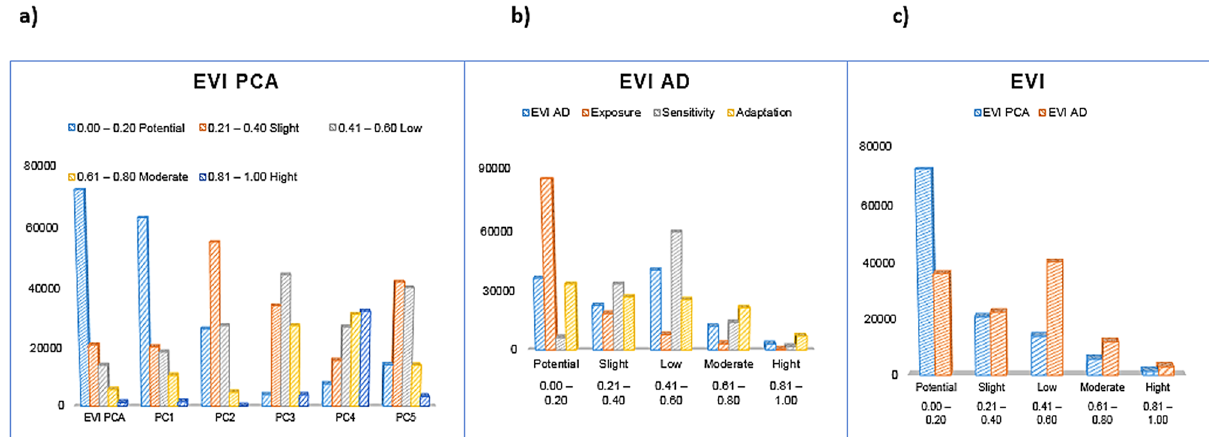
Figure 4. Classification areas